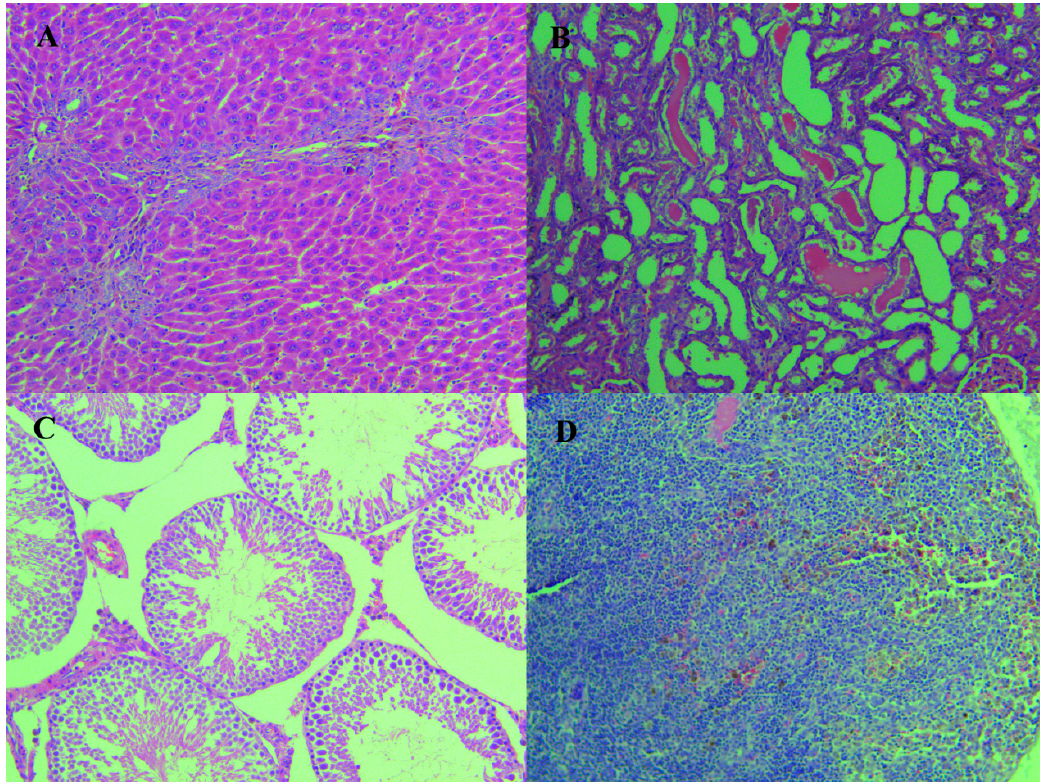
Figure 4. The presented images were the representatives of histopathologic changes of the live, kidney, lungs and lymphonodus in the high-dose group at the end of the 90 days administration. ( A ) (HE 10 × 20, hyperpigmentation), ( B ) (HE 10 × 20, Degeneration, necrosis, pigmentation of renal tubular epithelial cells), ( C ) (HE 10 × 20, Testicular interstitial pigmentation) and ( D ) (HE 10 × 20, Proliferation of macrophages and pigmentation in lymph nodes).